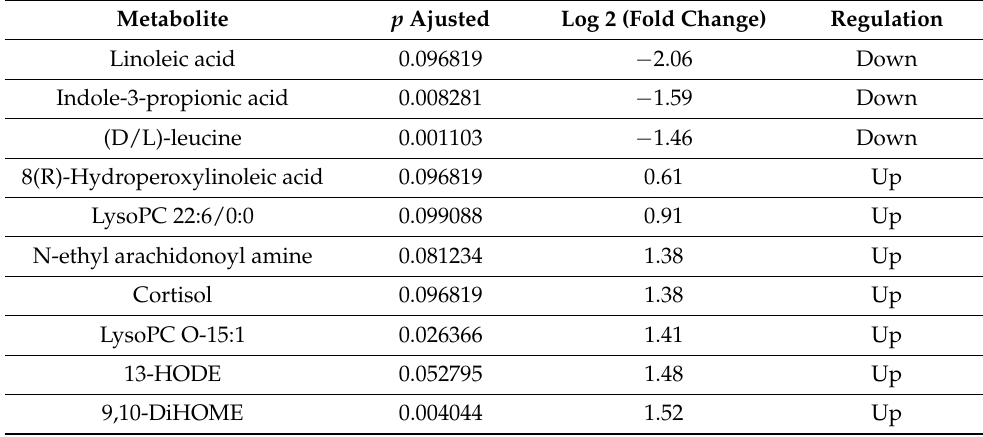
Table 2. Non-targeted metabolites differed significantly in NASH-HCC as compared to NASH patients.